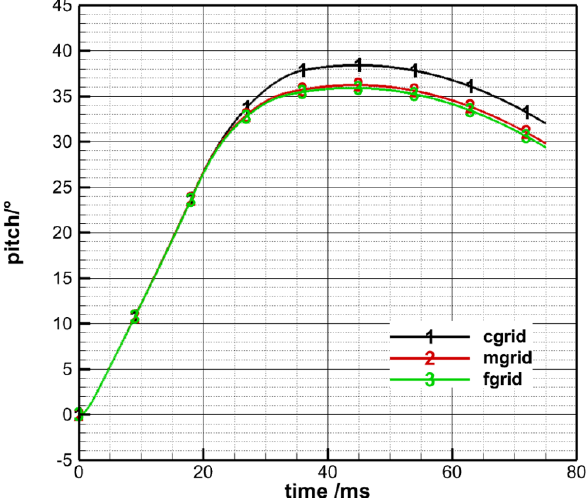
Figure 8. Mesh independency verification.